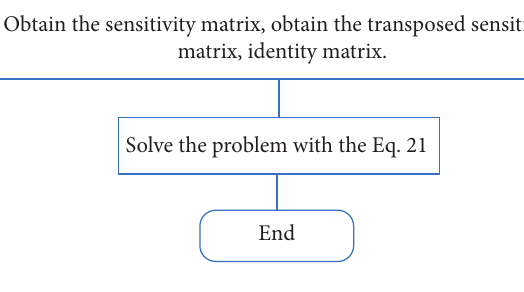
Figure 5. Diagram of the computational procedure.